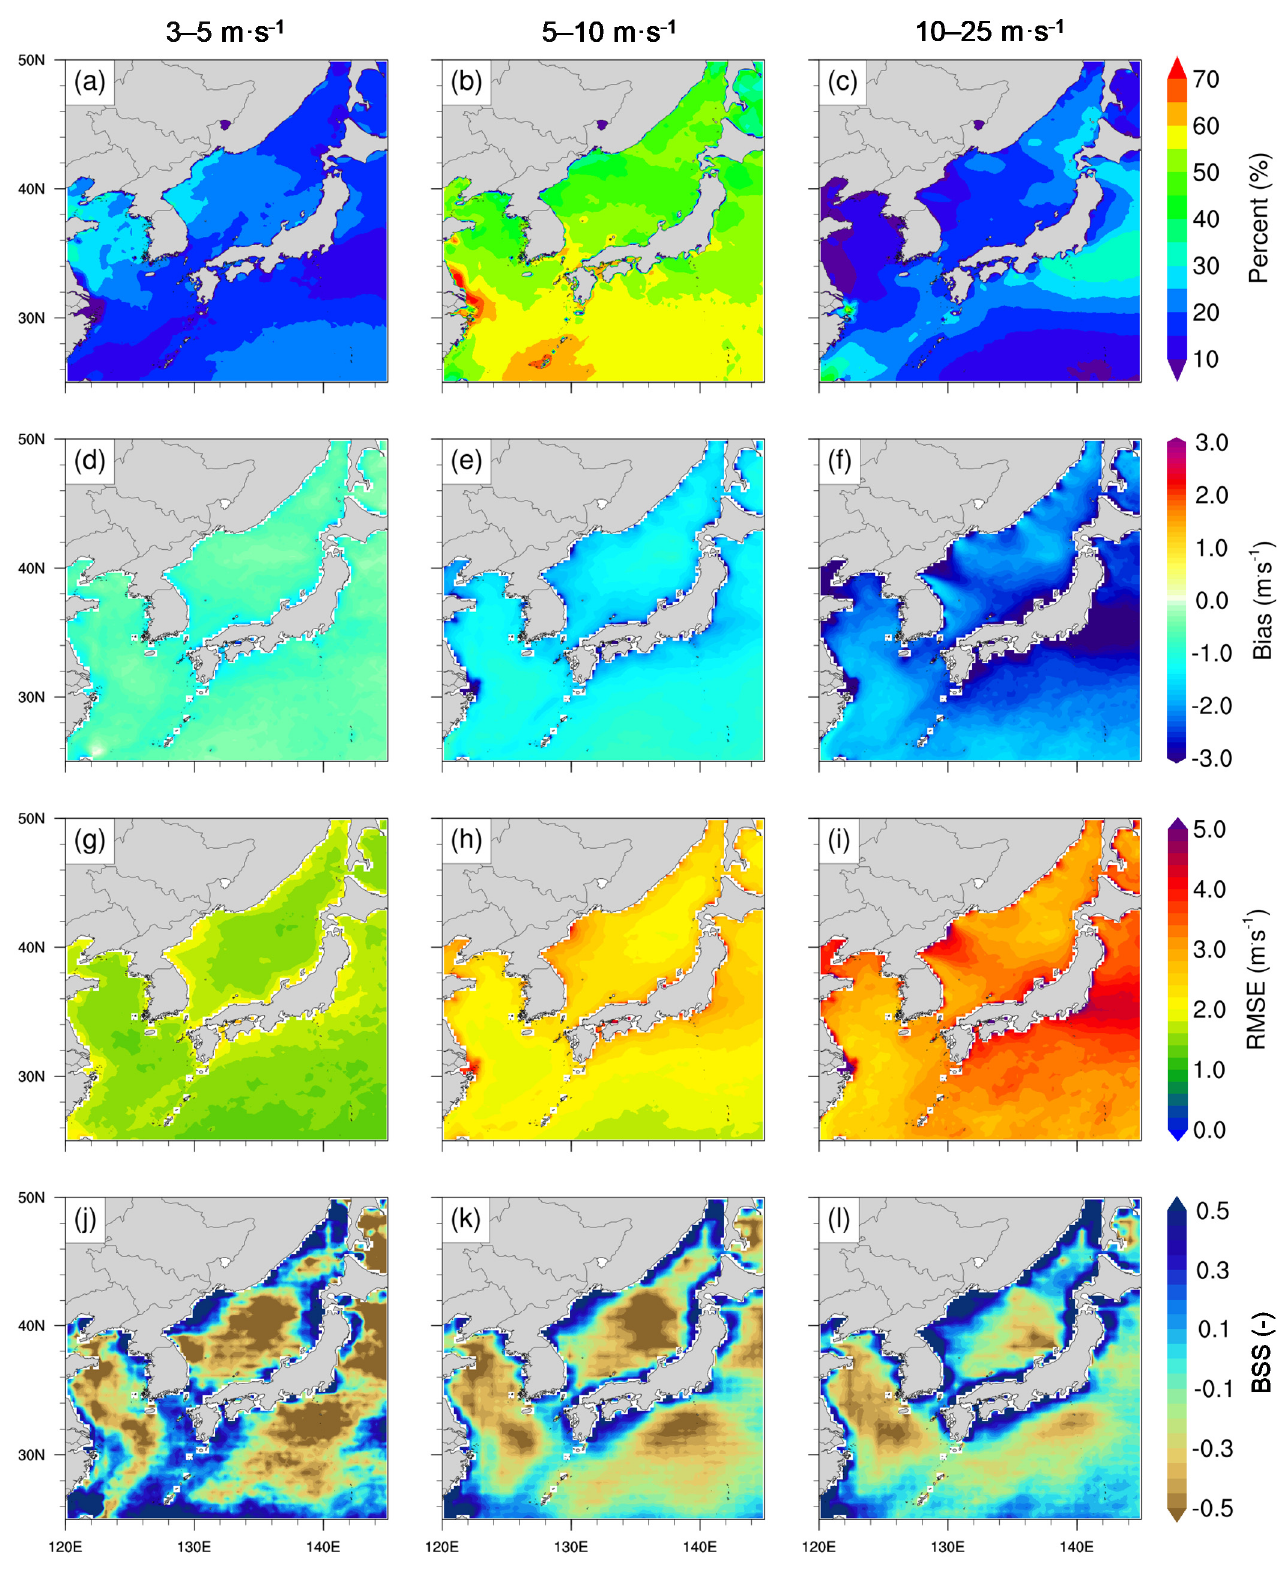
Figure 7. Spatial distributions of different wind intensities: 3–5 m·s − 1 ( a , d , g , j ); 5–10 m·s − 1 ( b , e , h , k ); and 10–25 m·s − 1 ( c , f , i , l ). ( a – c ) displays the percentage of each wind intensity within the valid range of DASCAT (3–25 m·s − 1 ), ( d – f ) shows the mean bias of hindcast and DASCAT data, ( g – i ) displays the RMSE of hindcast and DASCAT data, and ( j – l ) display the BSS of the hindcast relative to ERA-Interim when DASCAT is considered as “True”.